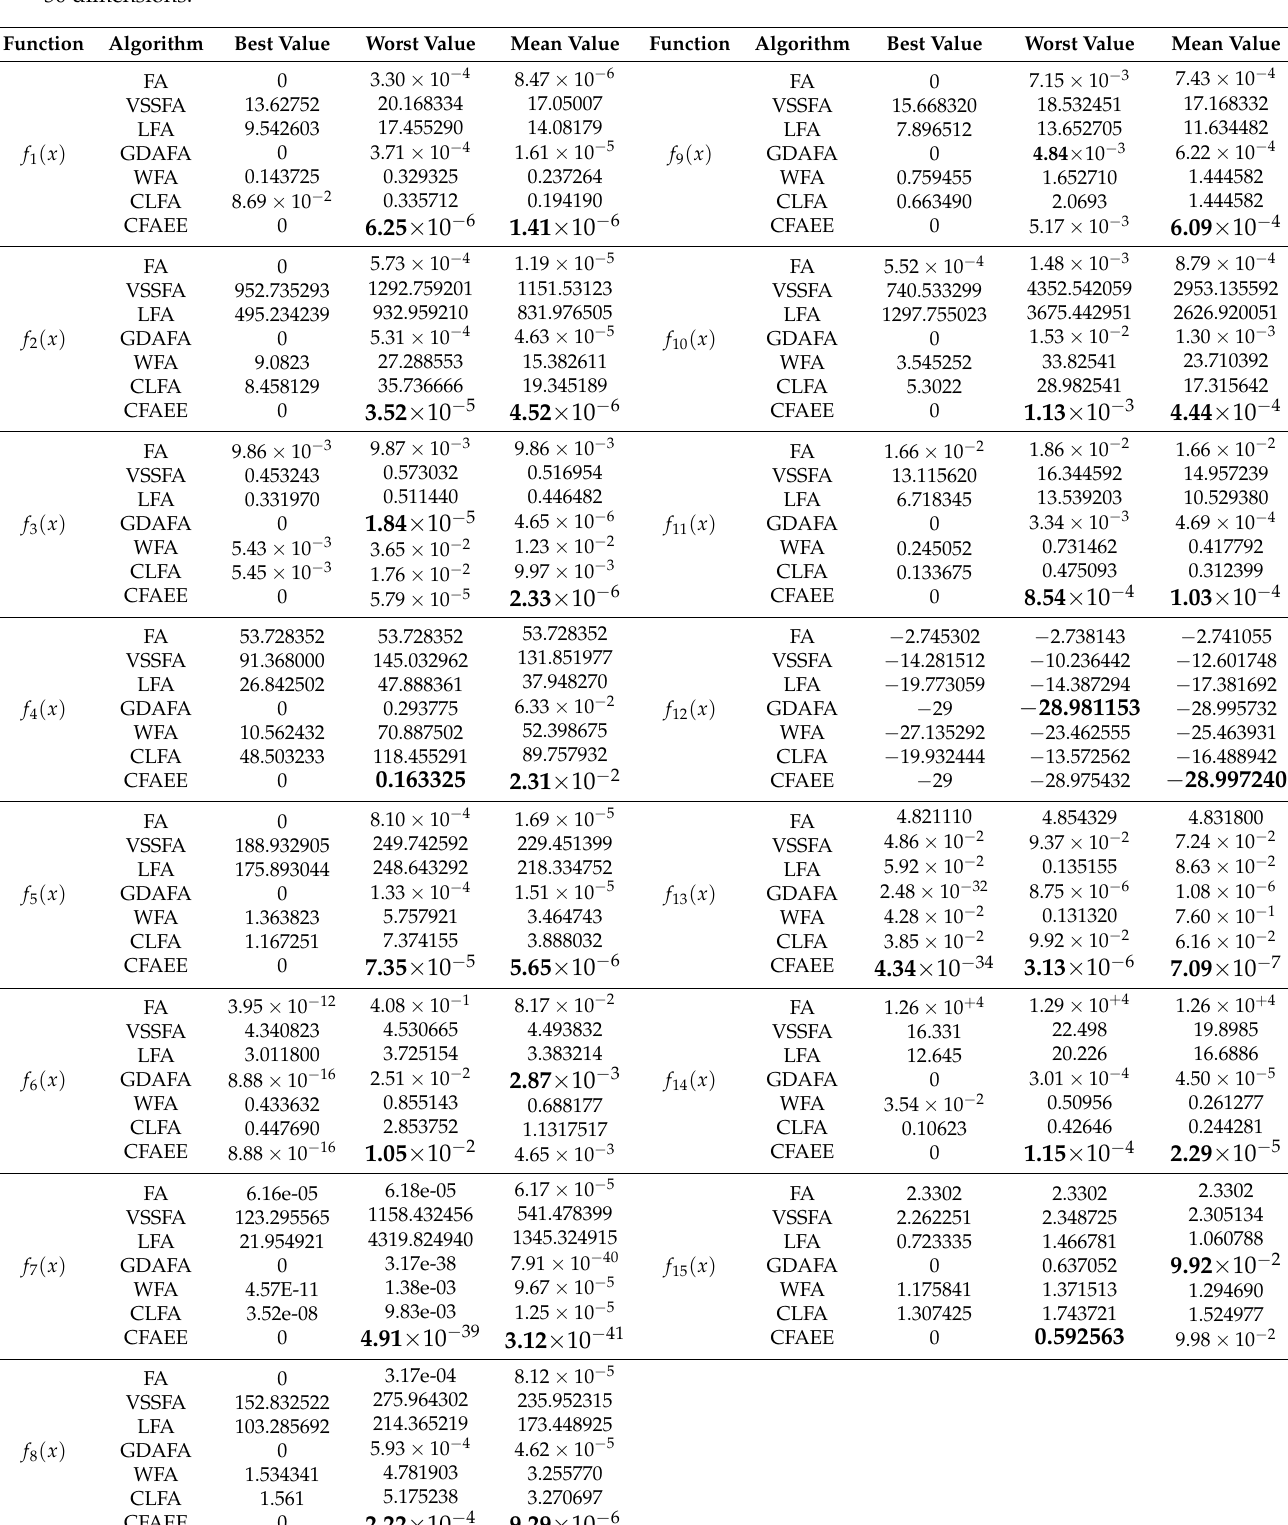
Table 4. Comparative analysis among CFAEE, original FA, and five other FA implementations for benchmarks with 30